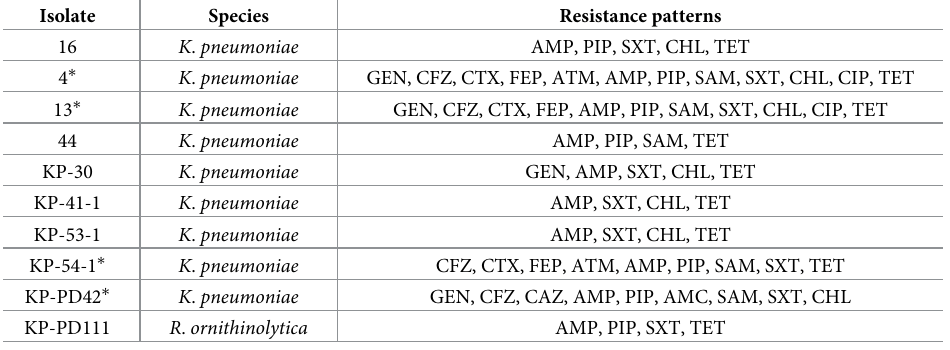
Table 3. Resistance patterns of MDR